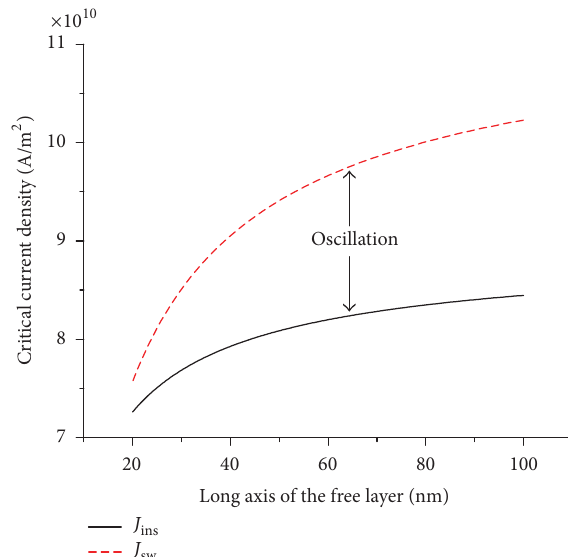
Figure 5: The critical current densities obtained from macrospin model and micromagnetic